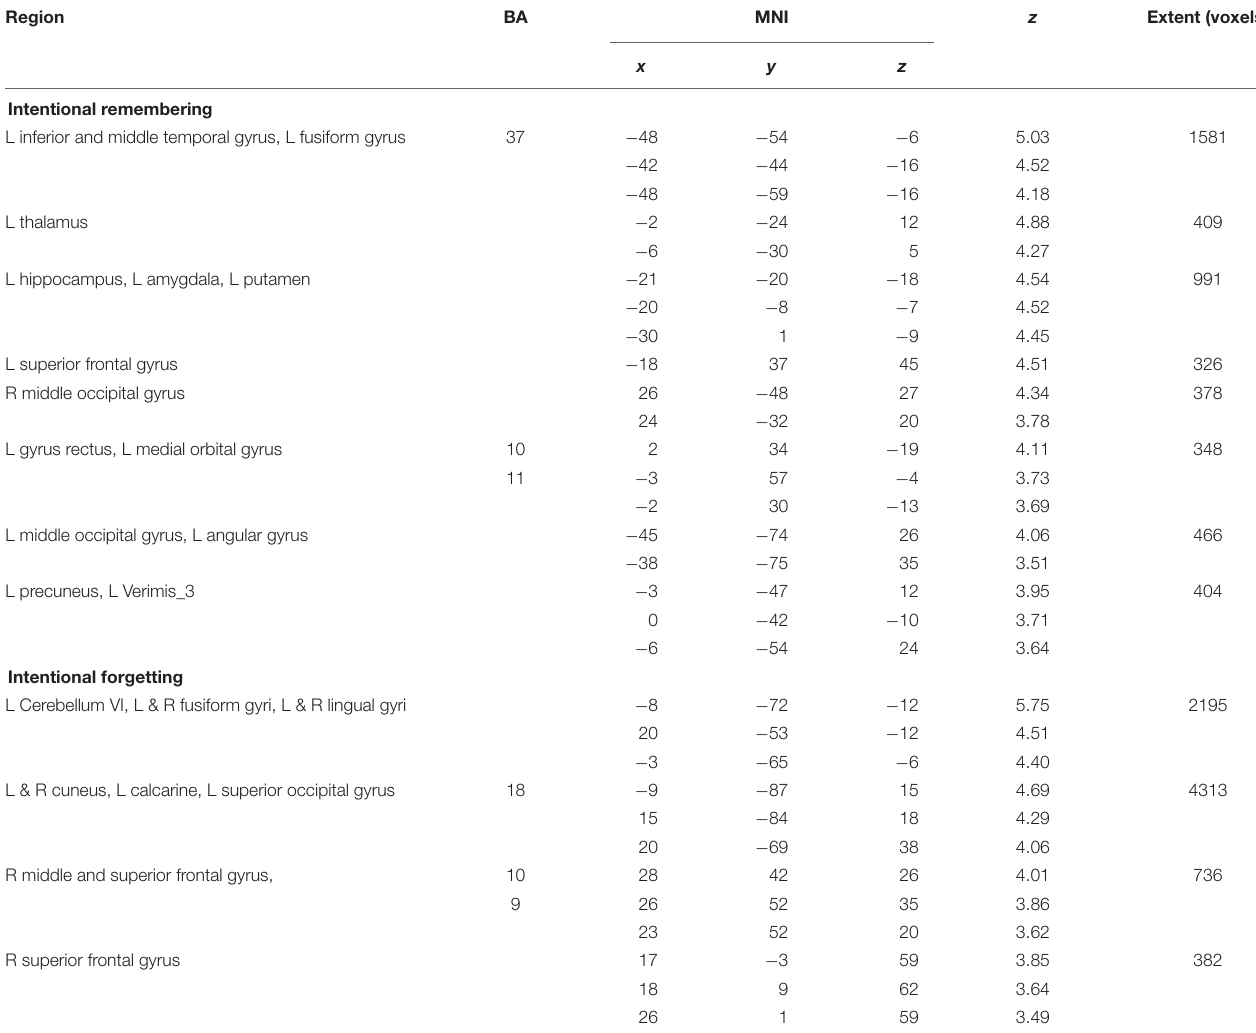
TABLE 3 | Peak level activations for the intentional remembering and forgetting contrasts at peak level, FWE cluster corrected at p < 0.05. Region BA MNI z Extent (voxels) x y